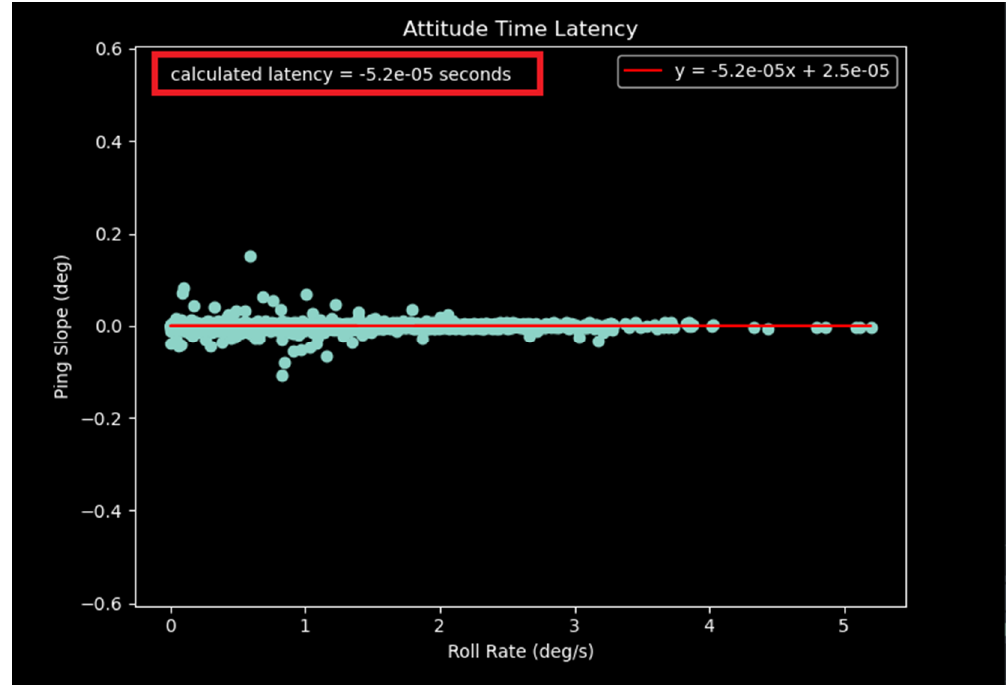
8 Figure 6. Patch Test Area with an 8.0 m resolution gridded dataset of the processed multibeam data. The latency test involves isolating a line over flat seafloor that was acquired with, ideally, a significant amount of roll. This dataset can be analyzed using the Kluster Ad- vanced Plots – Wobble Test tool to determine if there is a correlation between the roll rate